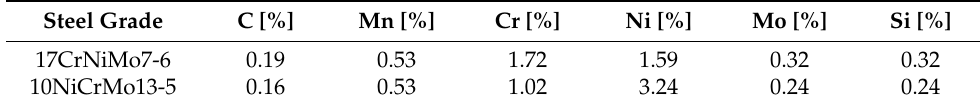
Table 1. Chemical composition of 10NiCrMo13-5 and 17CrNiMo 7-6 steels. Steel